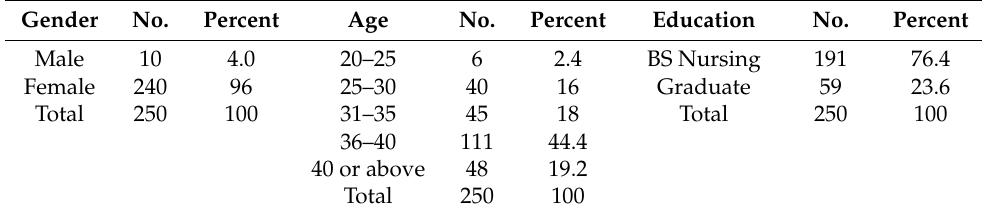
Table 2. Demographic valuation.